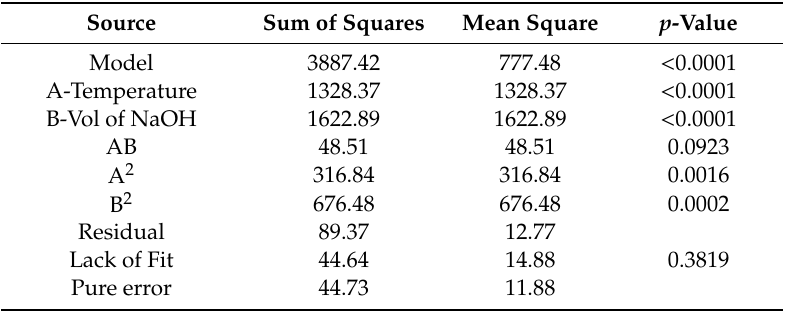
Table 4. Analysis of variance (ANOVA) for the quadratic